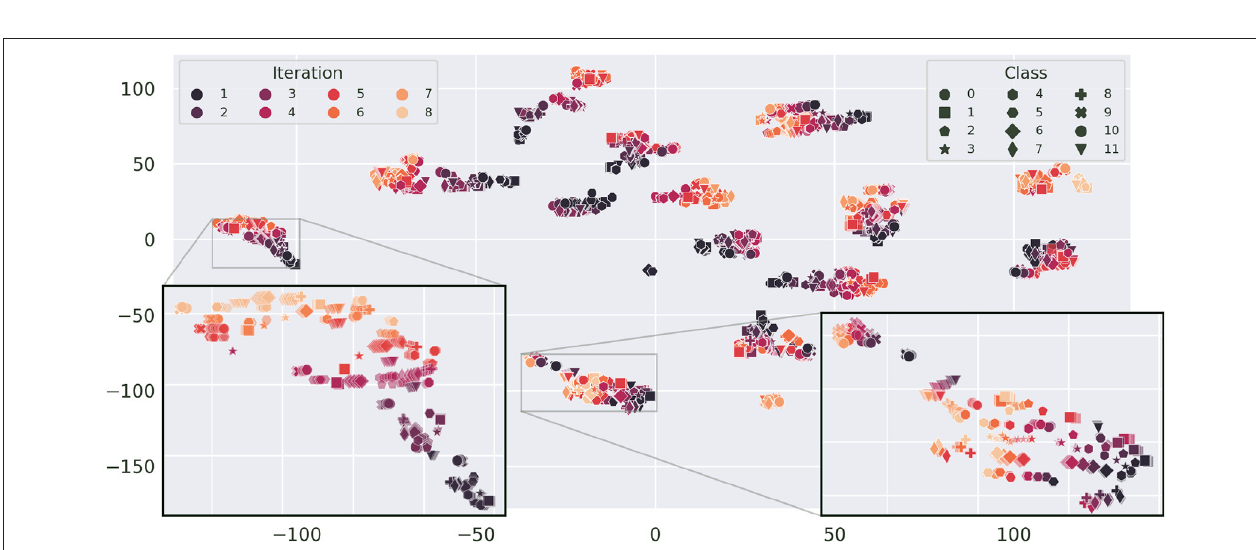
FIGURE 8 | t-SNE projection of the 256-dimensional data space of raw measurements colored by session (perplexity = 90). Annotations indicate the mean sample position of a session cluster and the markers show which subject each sample comes from.